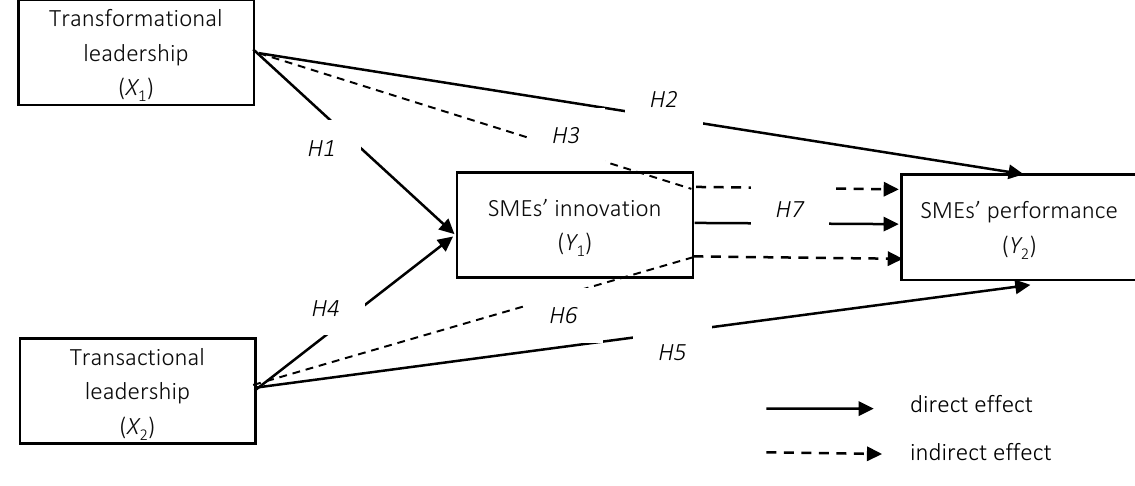
Figure 1. Research conceptual